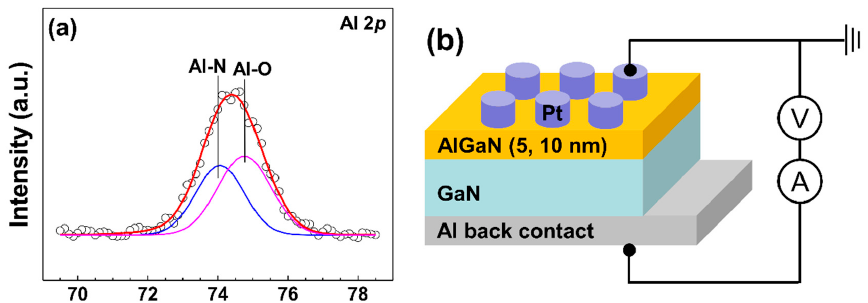
Figure 1. ( a ) X-ray photoelectron spectroscopy (XPS) Al 2 p core-level spectrum obtained from 10 nm thick AlGaN surface and ( b ) schematic layer structures of the devices.